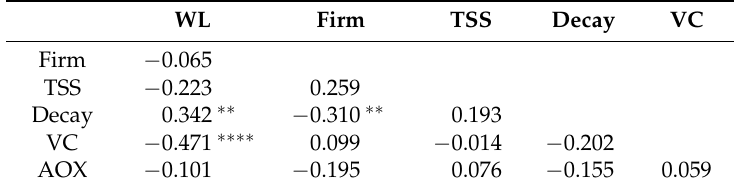
Table 4. Correlation coefficients of weight loss (WL), elasticity (Firm), sugar content (TSS), decay, vitamin C (VC) and antioxidant activity (AOX) in red pepper after 14 days at 7 ◦ C plus three days at 20 ◦ C. WL Firm TSS Decay VC